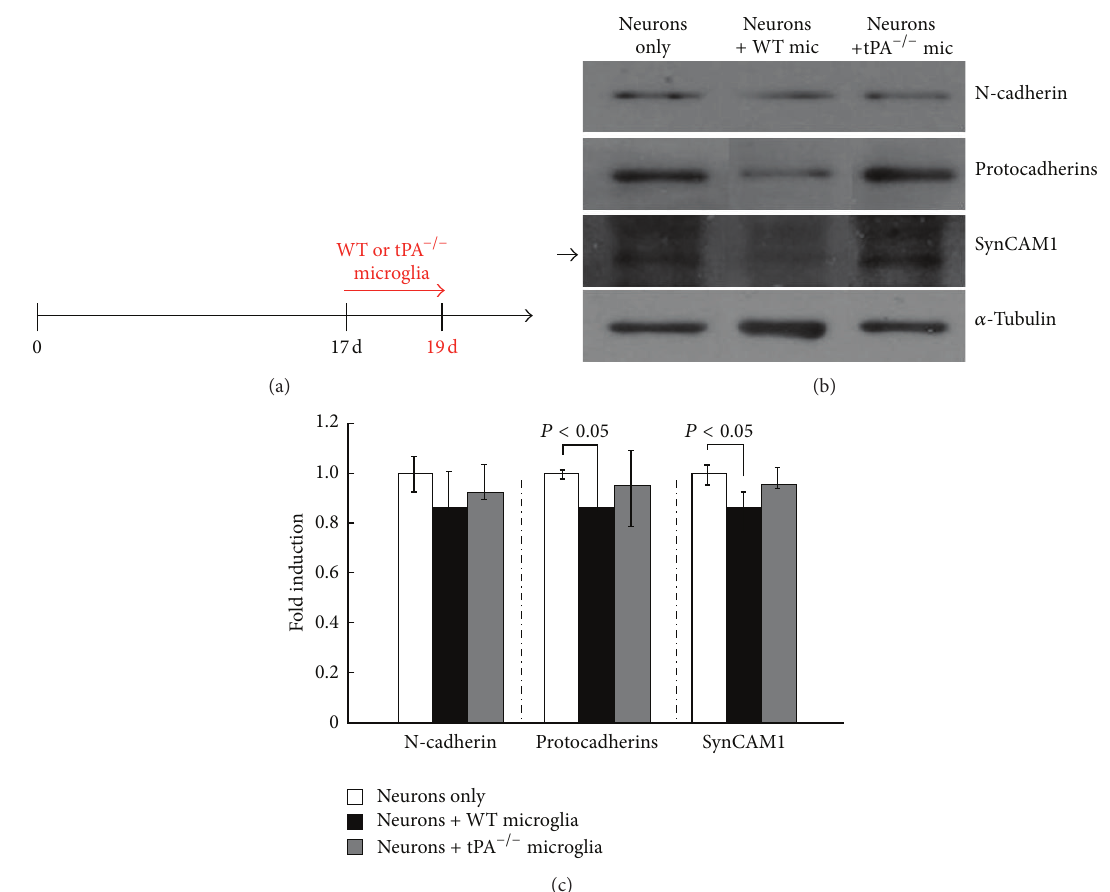
Figure 2: Microglial tPA deficiency preserves the levels of synaptic adhesion molecules. (a) Hippocampal neurons at 19 DIV were cocultured with microglia for 2 days. (b) The western blot analysis of the levels of N-cadherin, pan- 𝛾 -protocadherin, and SynCAM-1 in neurons in the absence or presence of microglia from wild-type (WT) or tPAKO ( tPA −/− ) mice. 𝛼 -Tubulin was used as a loading control. (c) Quantification was performed using the ImageJ software and normalized against 𝛼 -tubulin ( 𝑛 = 4 ). ∗ 𝑃 < 0.05 compared to neurons